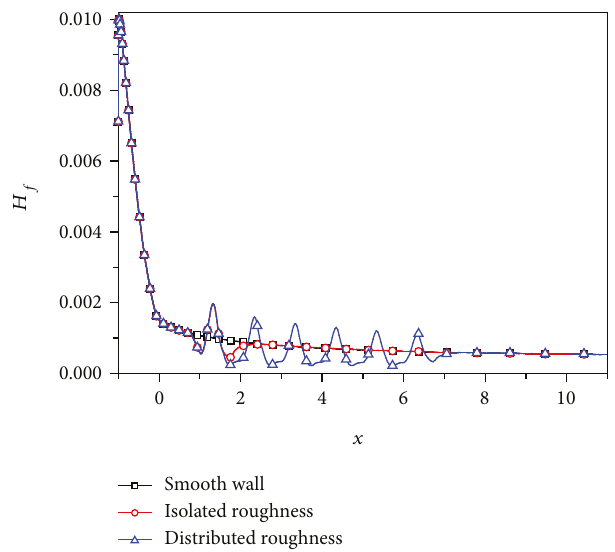
Figure 6: The distribution of heat fl ux of the wall along the fl ow direction.